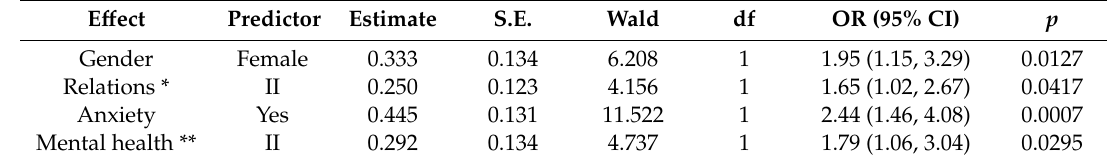
Table 12. Prediction of awake bruxism (AB) aggravation in Israel.